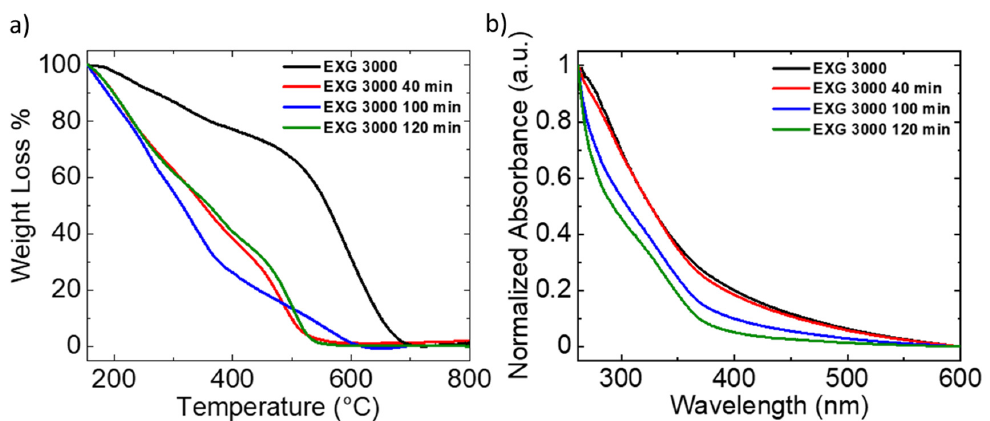
Figure 6. ( a ) Thermograms in air of the ultrasonicated EXG 3000 samples and of pristine EXG 3000. ( b ) UV–visible absorption spectra of the ultrasonicated EXG 3000 samples and of pristine EXG 3000.